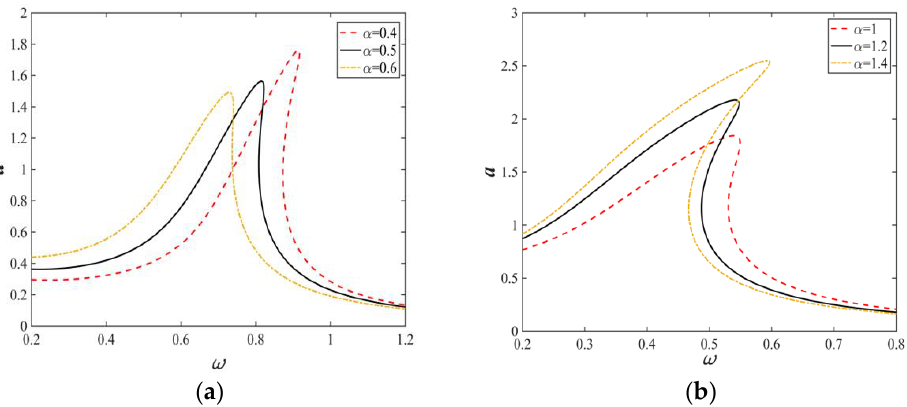
Figure 8. Amplitude and frequency characteristic curves of the system under different α : ( a ) 0 < α < 1 ; ( b ) 1 < α < 2 .